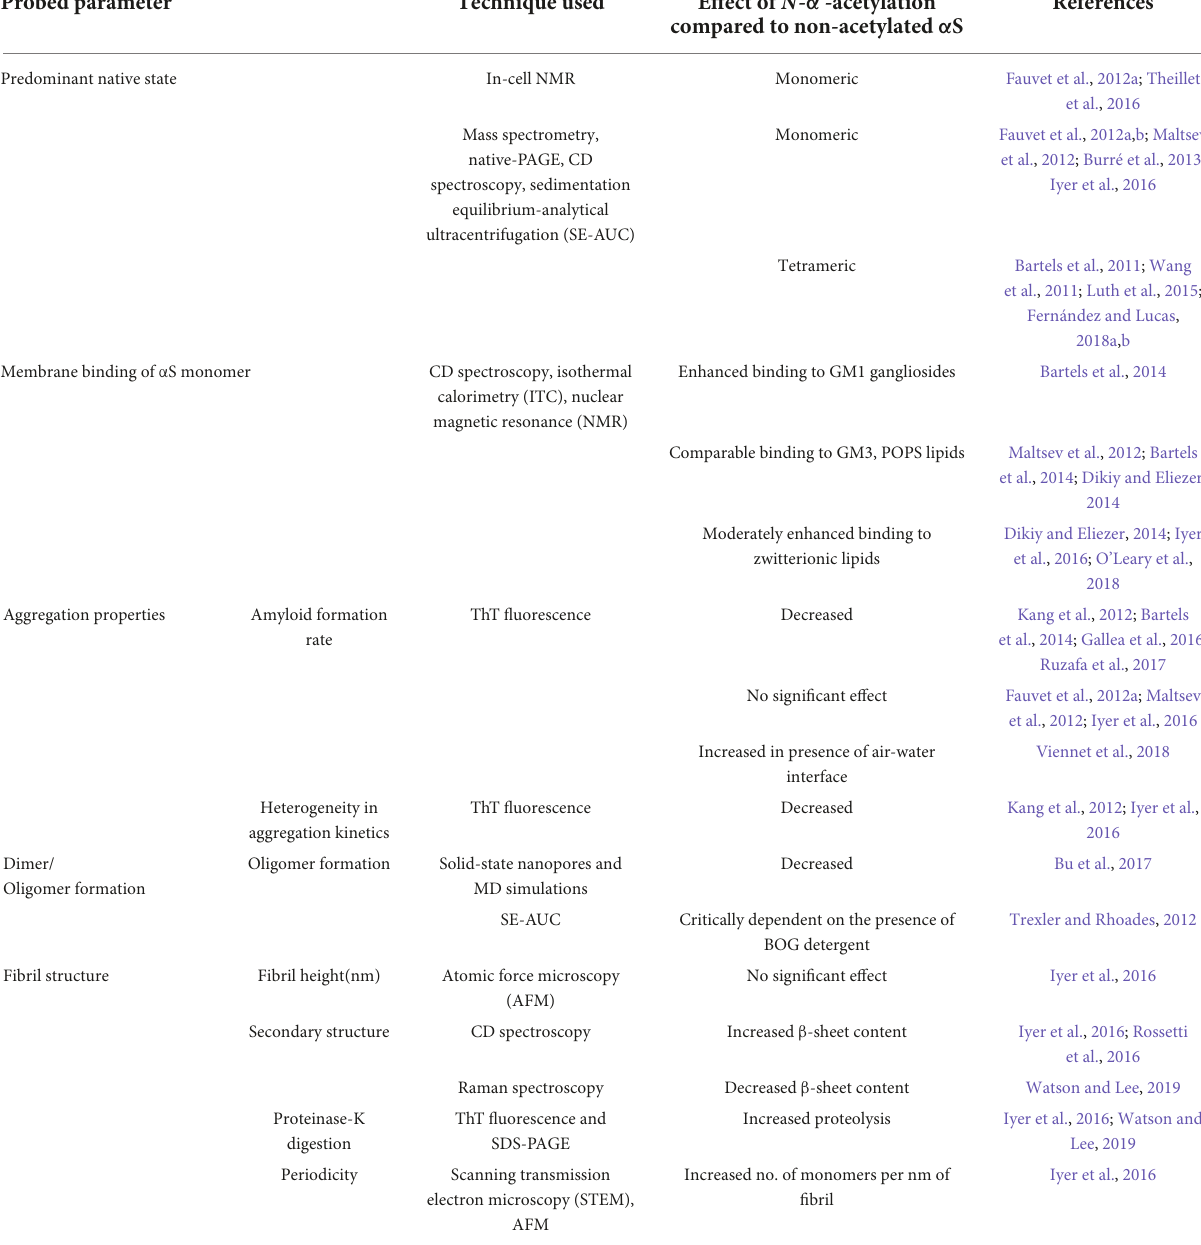
TABLE 1 Effect of N-terminal acetylation on biophysical properties of α